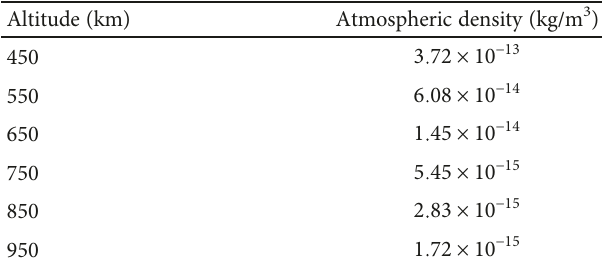
Table 3: Atmospheric annual mean density in di ff erent